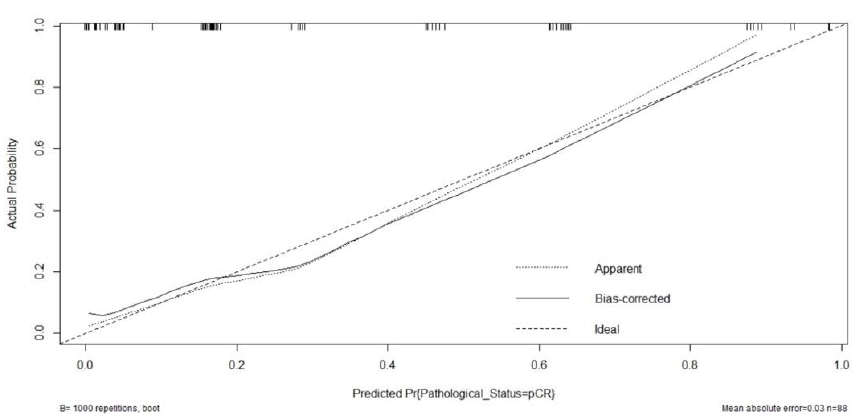
Figure 4. The calibration curve is based on internal validation with a bootstrap resampling frequency of 1000.